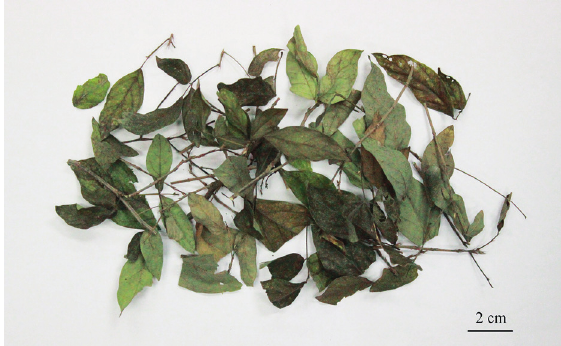
Figure 2 - The medicinal materials of Desmodium caudatum. Bars: 2 cm.